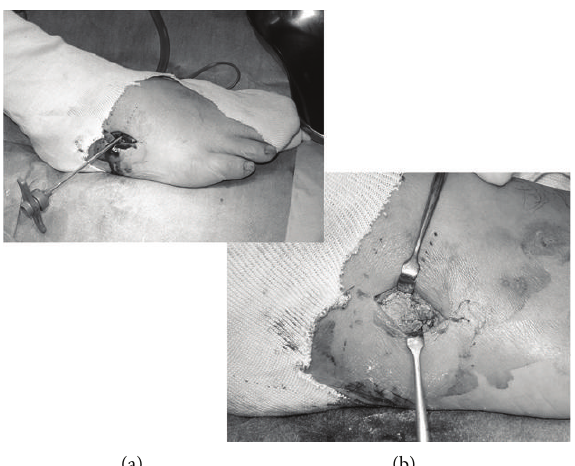
Figure 5: Intraoperative findings. (a) Artificial bone was applied into a large defect of the bone using a bone biopsy needle. (b) Appearance after the defect had been filled with artificial bone.